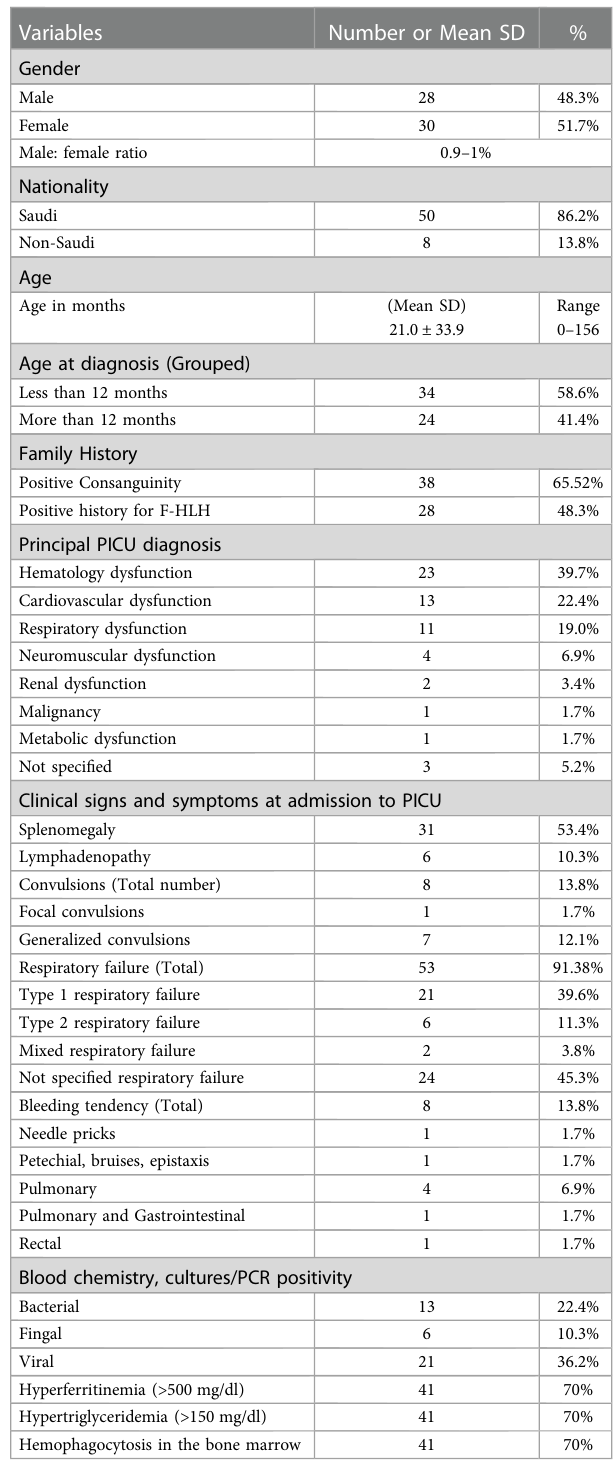
TABLE 1 Demographic and clinical characteristics of studies patients diagnosed with F-HLH.